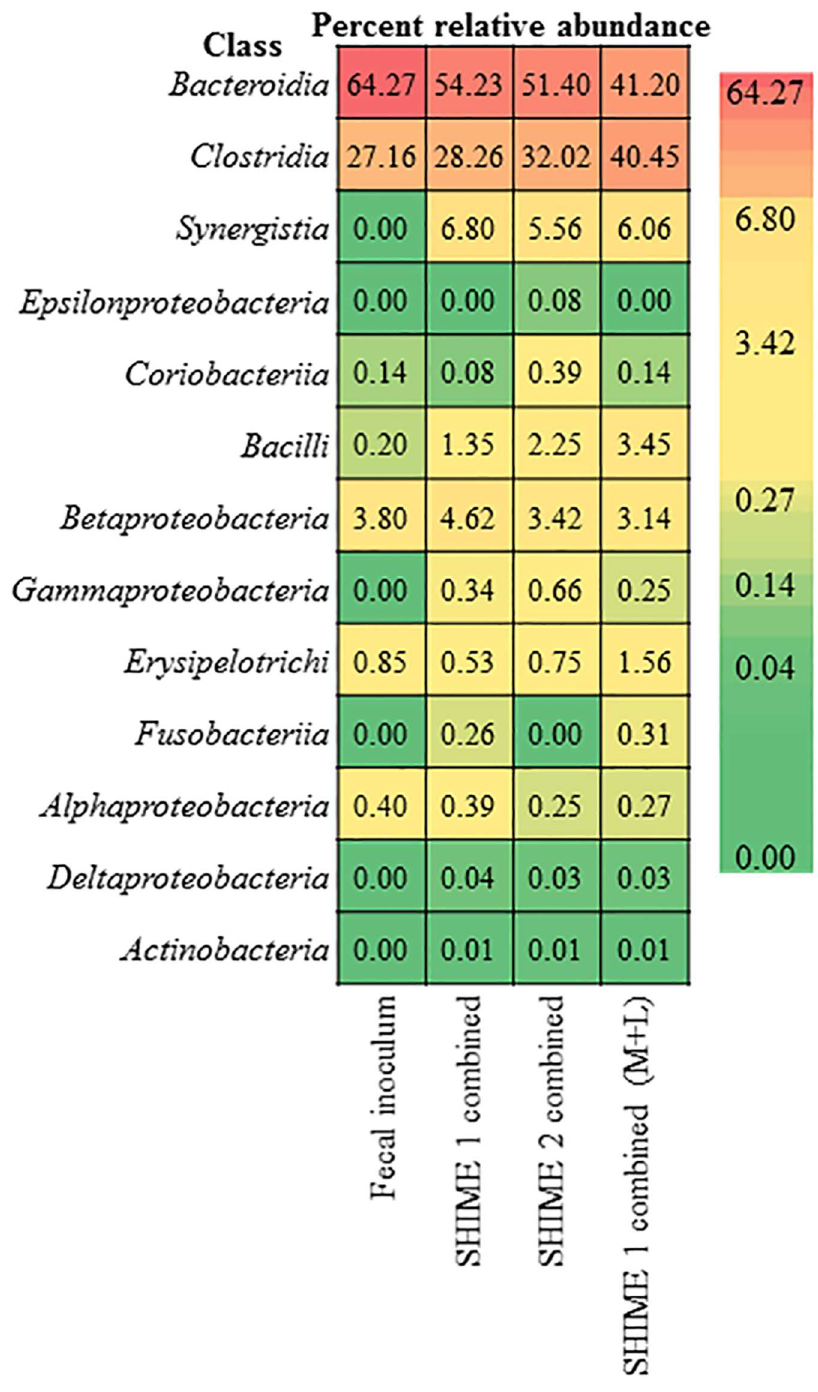
Fig 7. Comparison of the combined communities for each SHIME system to the fecal inoculum. SHIME 1 combined and SHIME 2 combined is the sum of the luminal phases for the AC, TC, and DC regions from day 10–43; SHIME 1 combined (M+L) is the sum of the luminal and mucosal phases of the AC, TC, and DC regions from day 10– 43.